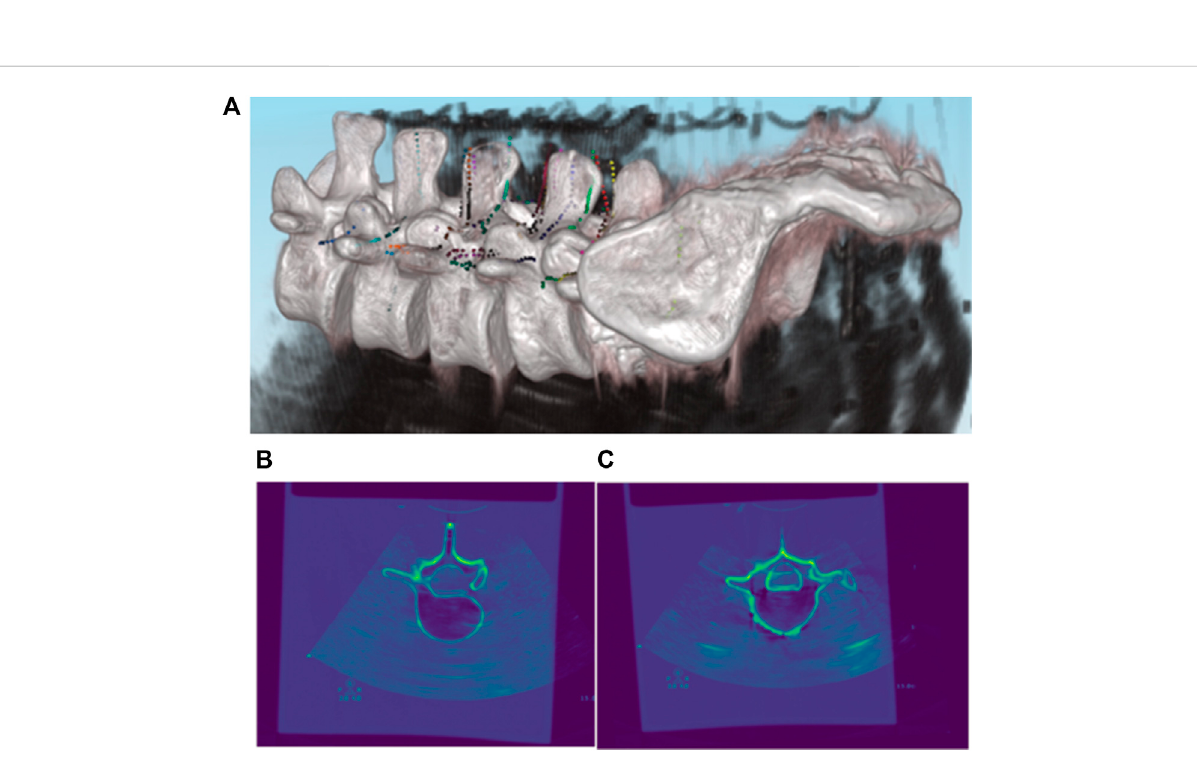
FIGURE 8 Registrationresults ofpre-operativeCTandintra-operative3DUS. (A) 3DRenderingofco-registeredCTandUSimages; (B,C) 2DRenderingof co-registered CT and US